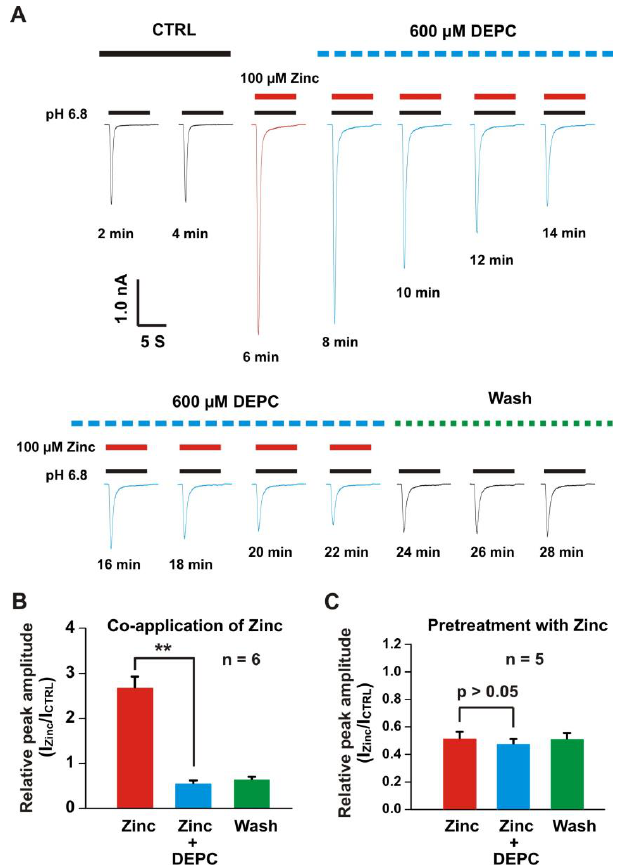
Figure 6. Histidine modifier DEPC blocked the zinc effects on heteromeric ASIC1a/3 channels. ( A ) Representative traces show the time course of the treatment with and without the DEPC (0.6 mM) on potentiation of heteromeric ASIC1a/3 currents by co-application of 100 µM zinc. Treatment with histidine modifying agent DEPC at a concentration of 0.6 mM inhibited the potentiation of heteromeric ASIC1a/3 currents during the incubation. This was recorded in the same cell by different treatments and the current trace was recorded every 2 min. The dashed blue line represents pretreatment with DEPC in the pH 7.4 solution, the dashed green line represents washout with normal pH 7.4 solution, and the solid red and black lines represent 100 µM zinc and pH 6.8 application, respectively (each recoding with 7 s of zinc application); ( B ) Statistical bar graphs show that relative peak amplitude of the ASIC1a/3 currents by zinc potentiation was blocked in the presence of 0.6 mM DEPC ( n = 6); ( C ) Statistical bar graphs show that relative peak amplitude of the ASIC1a/3 currents by zinc inhibition was blocked in the presence of 0.6 mM DEPC ( n = 5). Whole-cell patch-clap recording was performed and heteromeric ASIC1a/3 currents were activated by a drop in pH from 7.4 to 6.8. Data are presented as mean ± SEM. CTRL, control; I CTRL , ASIC current without any treatment; I Zinc , ASIC current by zinc treatment. ** p < 0.01.